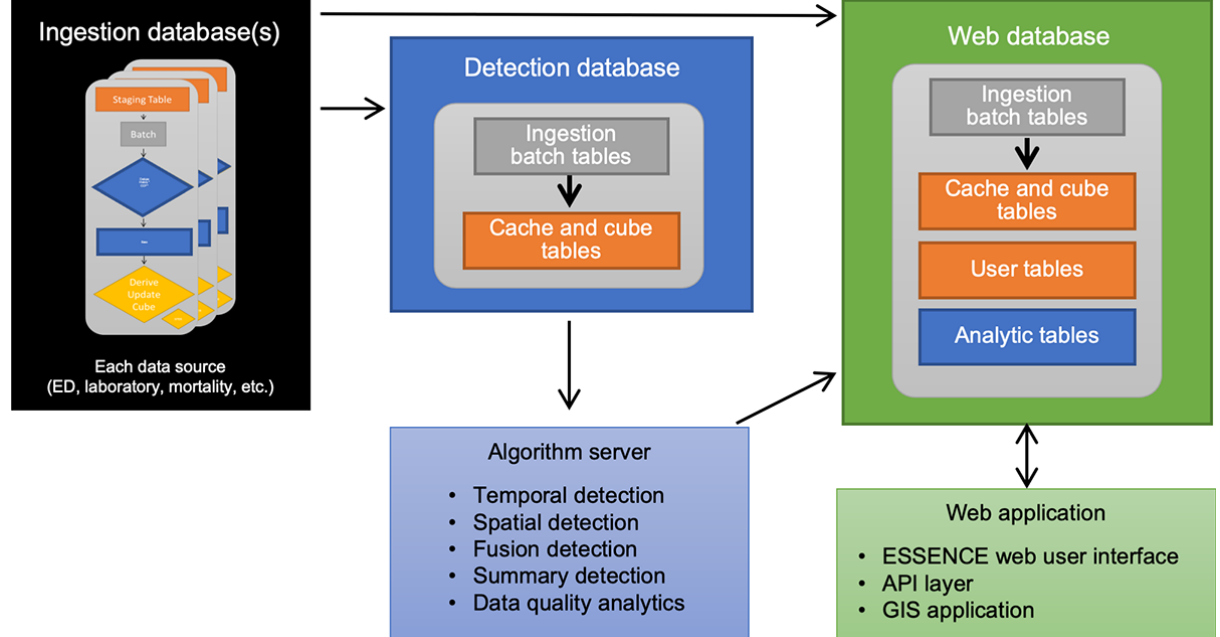
Figure 2. Flow diagram illustrating typical Electronic Surveillance System for the Early Notification of Community-Based Epidemics (ESSENCE) data flow with databases and tables, generalized to account for diversity among user needs and server configurations. API: application program interface; ED: emergency department; GIS: geographic information